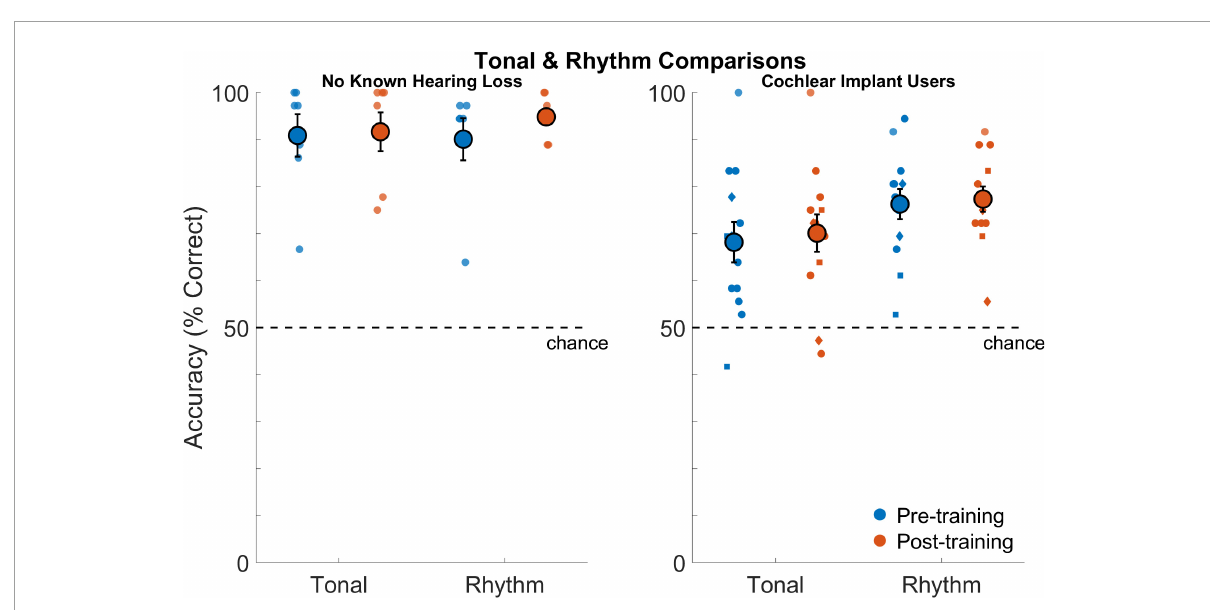
FIGURE5 Tonal and rhythm comparisons as percentage of correct responses for listeners with no known hearing loss (left subpanel) and for cochlear implant users (right subpanel). Smaller symbols indicate individual thresholds. Individual thresholds for cochlear implant users with implants from Cochlear Corporation are represented with a circle, Advanced Bionics with a diamond, and MED-EL with a square. Larger circles indicate group averages for each session with error bars indicating standard errors of the means.